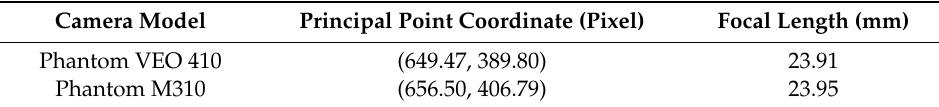
Table 2. Intrinsic parameters of the two